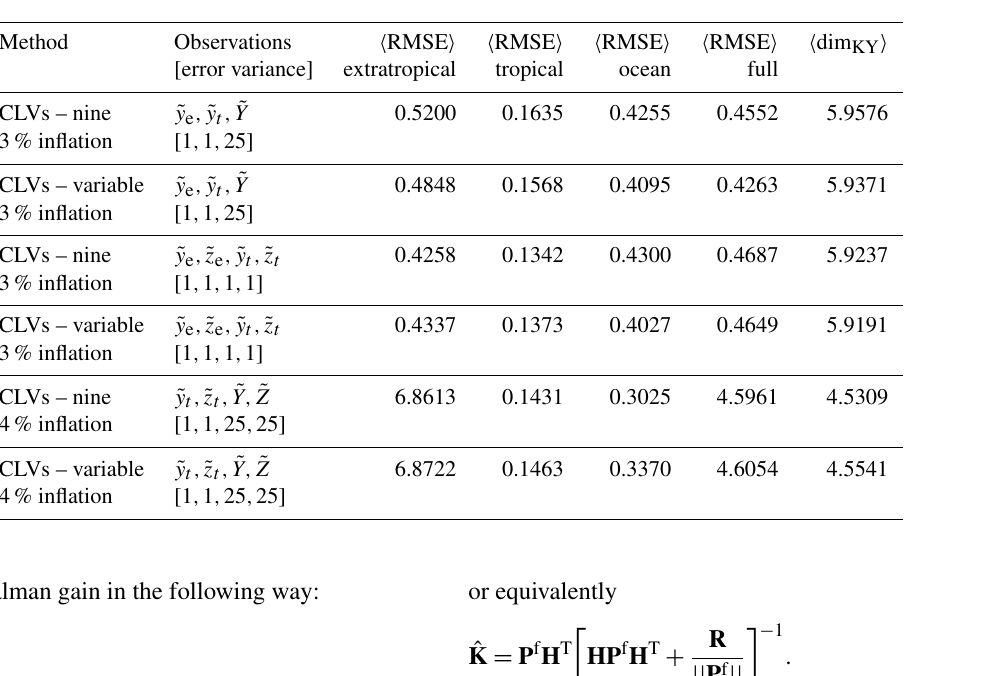
Figure 11. Comparison of the two different types of observations used in the data assimilation experiments. We show the observation space for the benchmark observations case ( y e , y t , Y ). A selection of 800 time steps (100 observations) of the control model (blue line) and values at the observation times (blue dots) are shown in both plots, along with the actual observations used (orange dots). The top figures show behaviour along the attractor and the bottom panels show y t in time. (a) Observations formed by random perturbations to control run points. (b) Observations taken from a trajectory which shadows the control run. Table 5. Summary metrics of DA experiments using a right-transform matrix (Eq. 15) and shadowed trajectory as observations. We set the observation error covariances to the standard values as in Yoshida and Kalnay (2018). Parameters: assimilation window 0.08, 11 ensemble members, inflation as noted in the